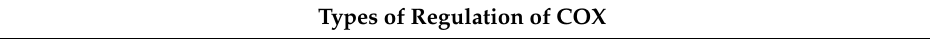
Table 1. COX regulation.